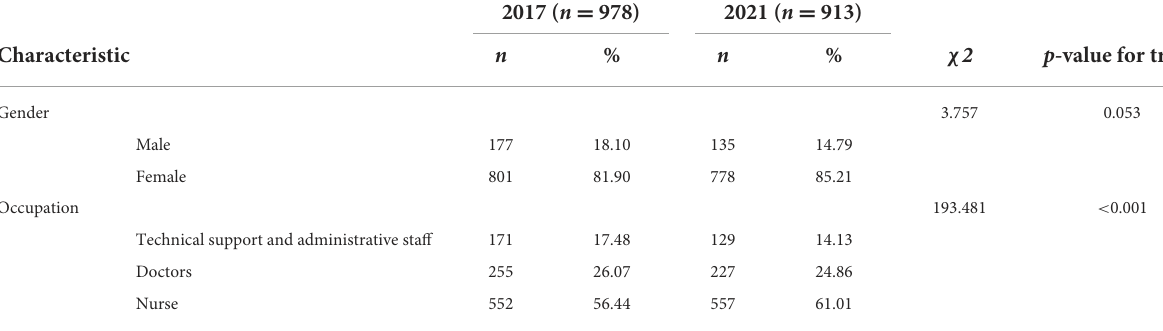
TABLE 1 Overview and description of HWs included by gender and